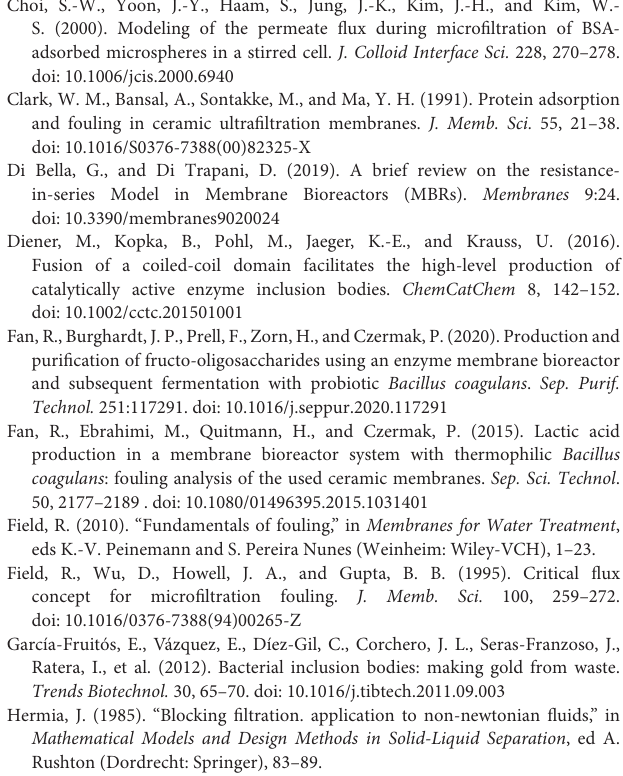
Supplementary Figure 1 | Steady-state flux as a function of OVA aggregate concentration. Vertical error bars are standard deviations from the Bradford assay ( n = 3) and horizontal error bars are standard deviations from the average steady-state flux during the last 5min of filtration. Filtrations were carried out at 1.5 bar TMP and 28 ◦ C with a 50nm cut-off ceramic membrane. The power fit of the gel polarization model gave the equation J ss = 12.5 × ln(1.6/c OVA ) with a correlation of adj. R ² =